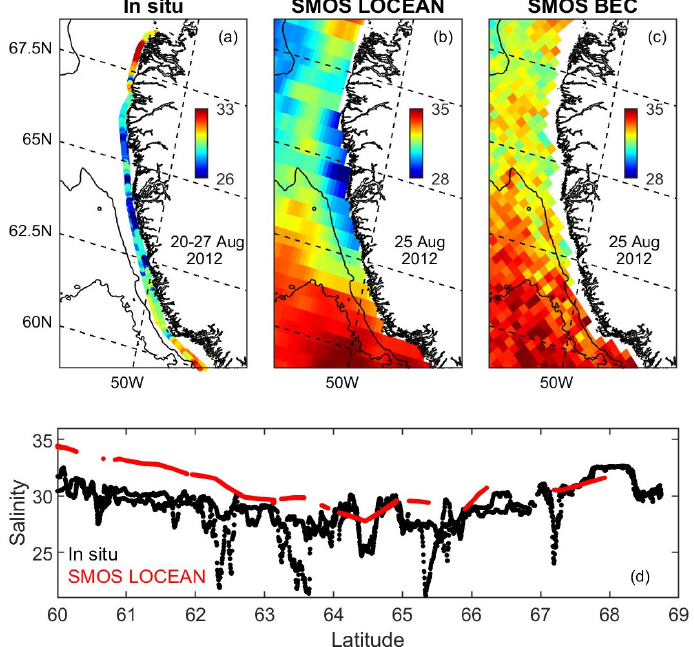
Figure 8. Surface salinity off west Greenland in late August 2012 based on ( a ) in situ thermosalino- graph data, ( b ) SMOS LOCEAN, and ( c ) SMOS BEC. Note that satellite salinities (panels ( b ) and ( c )) are generally 2–3 psu higher than in situ salinity ( a ), and, as such, the color bar in ( a ) is different than in ( b , c ) to reveal as much as possible of the spatial structure in each case. ( d ) Salinity from in situ data (black) and SMOS LOCEAN interpolated into the ship transect (red) are also shown as a function of latitude. SMOS BEC is not shown in ( d ) because of the wider coastal gap in that data set.